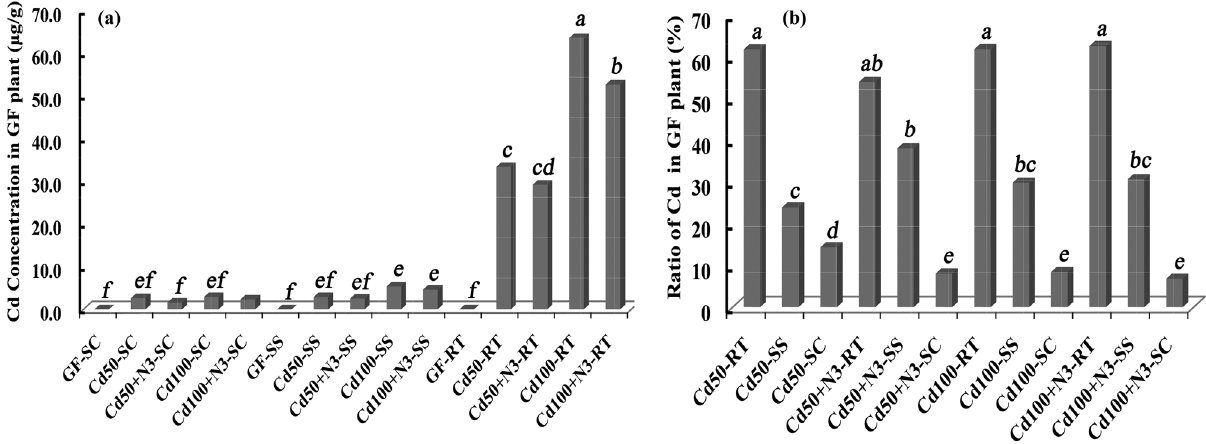
Figure 5: Concentrations of Cd in the shoot and root tissues of grafted plants. Signi fi cant di ff erences tested according to Duncan ’ s test at p < 0.01. ( a ) Cd concentration and ( b ) ratio of Cd in grafted plants. Values are the means ± standard deviations of three replicates. SC, scion; SS, rootstock shoot; RT, root.